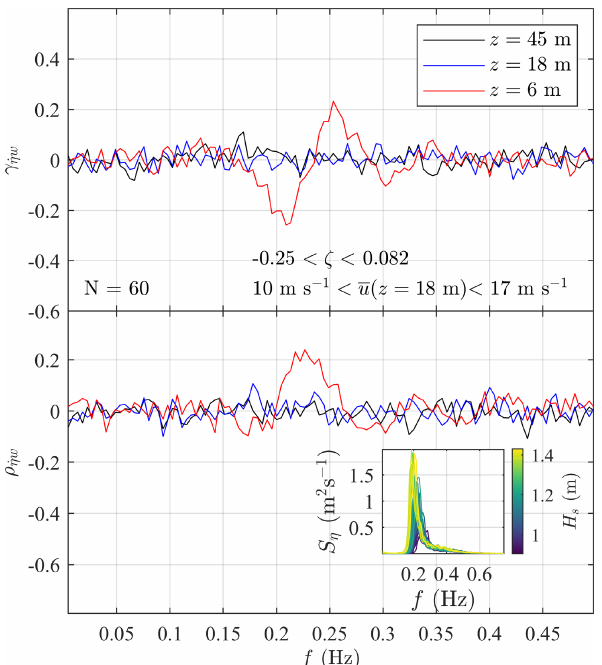
Figure 7. Co-coherence γ ˙ η w and quad-coherence ρ ˙ η w between the velocity of the wave surface ˙ η and the vertical wind velocity w from the three sonic anemometers on SMW. The inset shows the individ- ual wave elevation spectra S η associated with H s > 0 . 9m (60 sam- ples) used to estimate γ ˙ η w and ρ ˙ η w